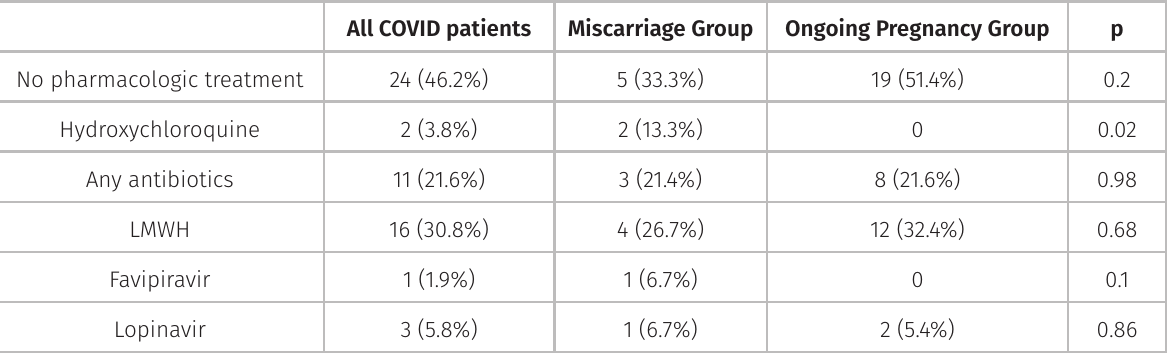
LMWH: Low molecular weight heparin. Chi-square test was performed. p: Comparison of Miscarriage Group and Ongoing Pregnancy